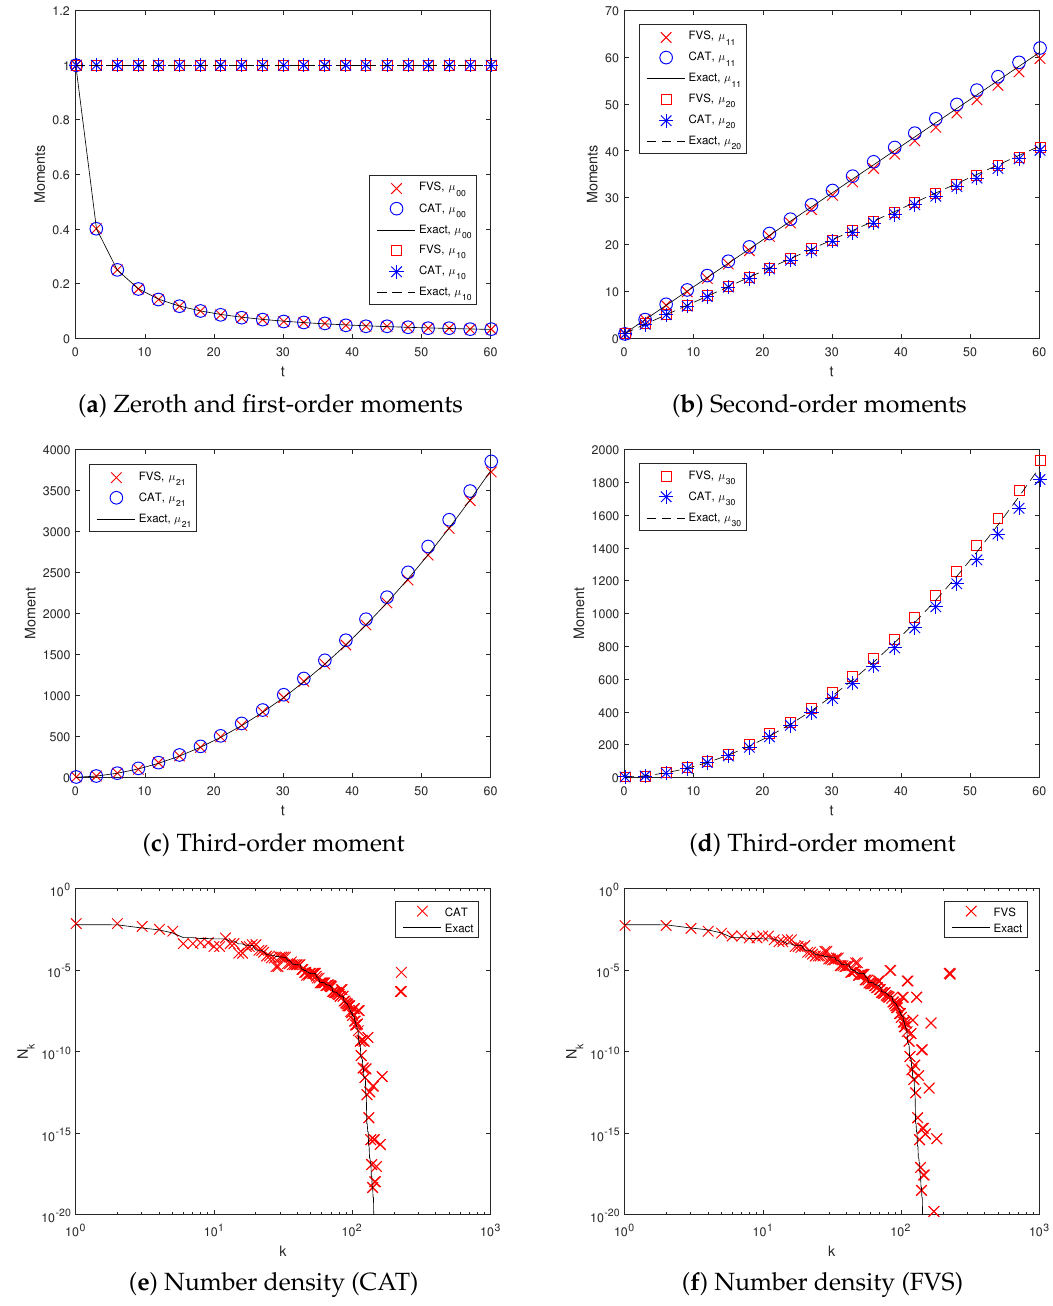
Figure 3. Different order moments and number density functions for constant